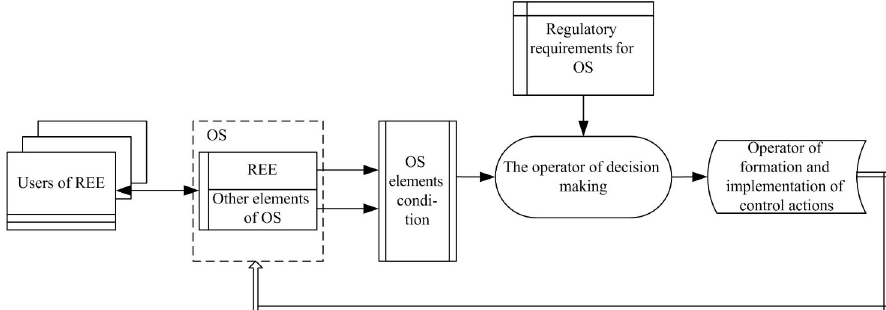
Figure 1. Block diagram of operation